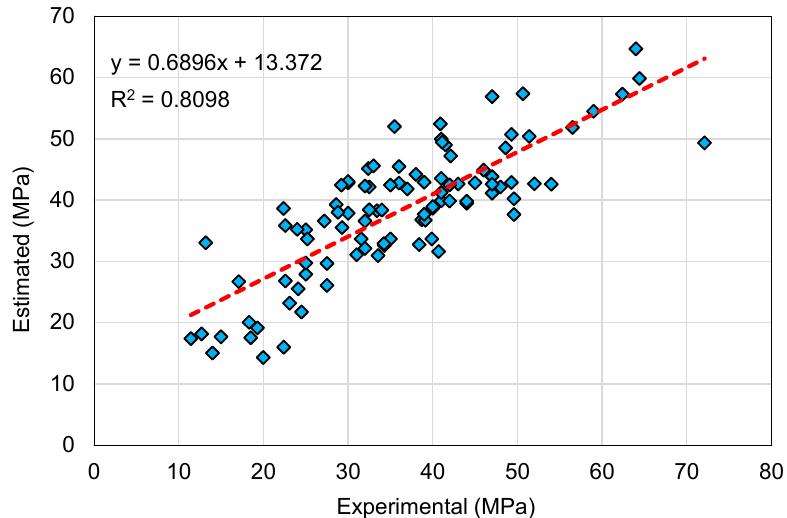
Figure 10. Relationship between experimental and estimated results for the multi-layer perceptron neural network model.